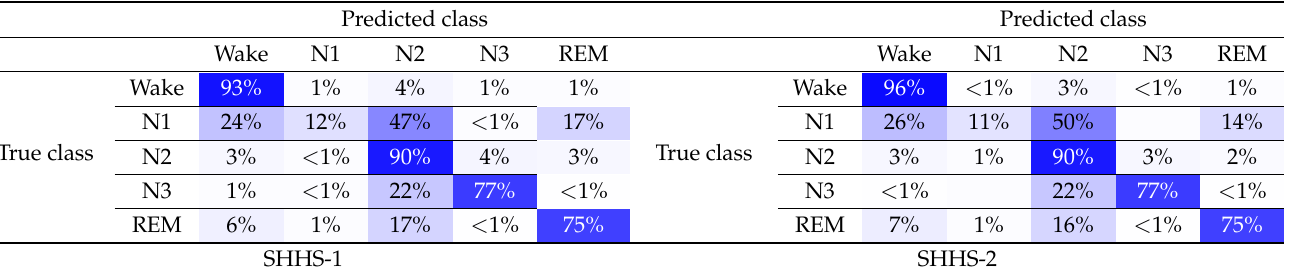
Table 7. Confusion matrix relating to five sleep stages’ classification by using combined signals with 10% hold-out